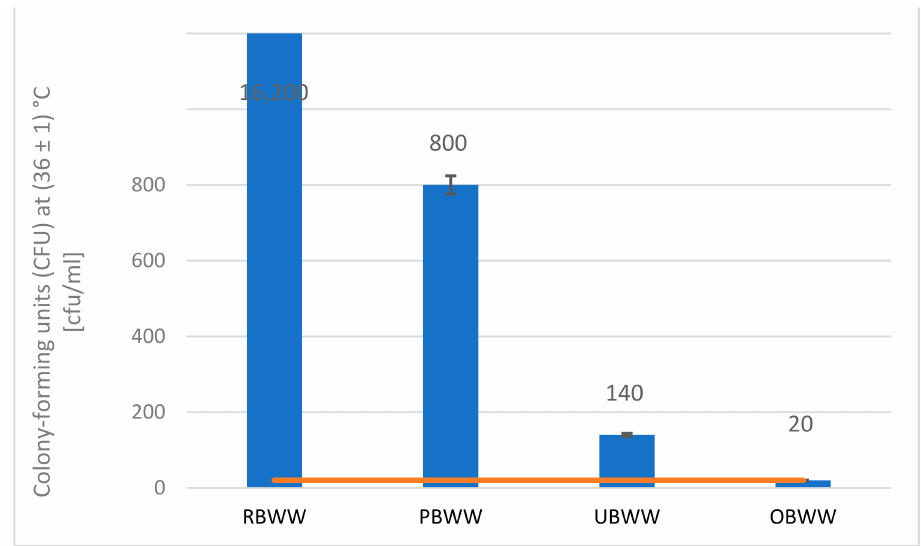
Figure 1. Change in CFU at (36 ± 1) ◦ C during the treatment process: raw backwash water (RBWW), pre-filter backwash water (PBWW), ultrafiltration backwash water (UBWW), ozonation backwash water (OBWW).